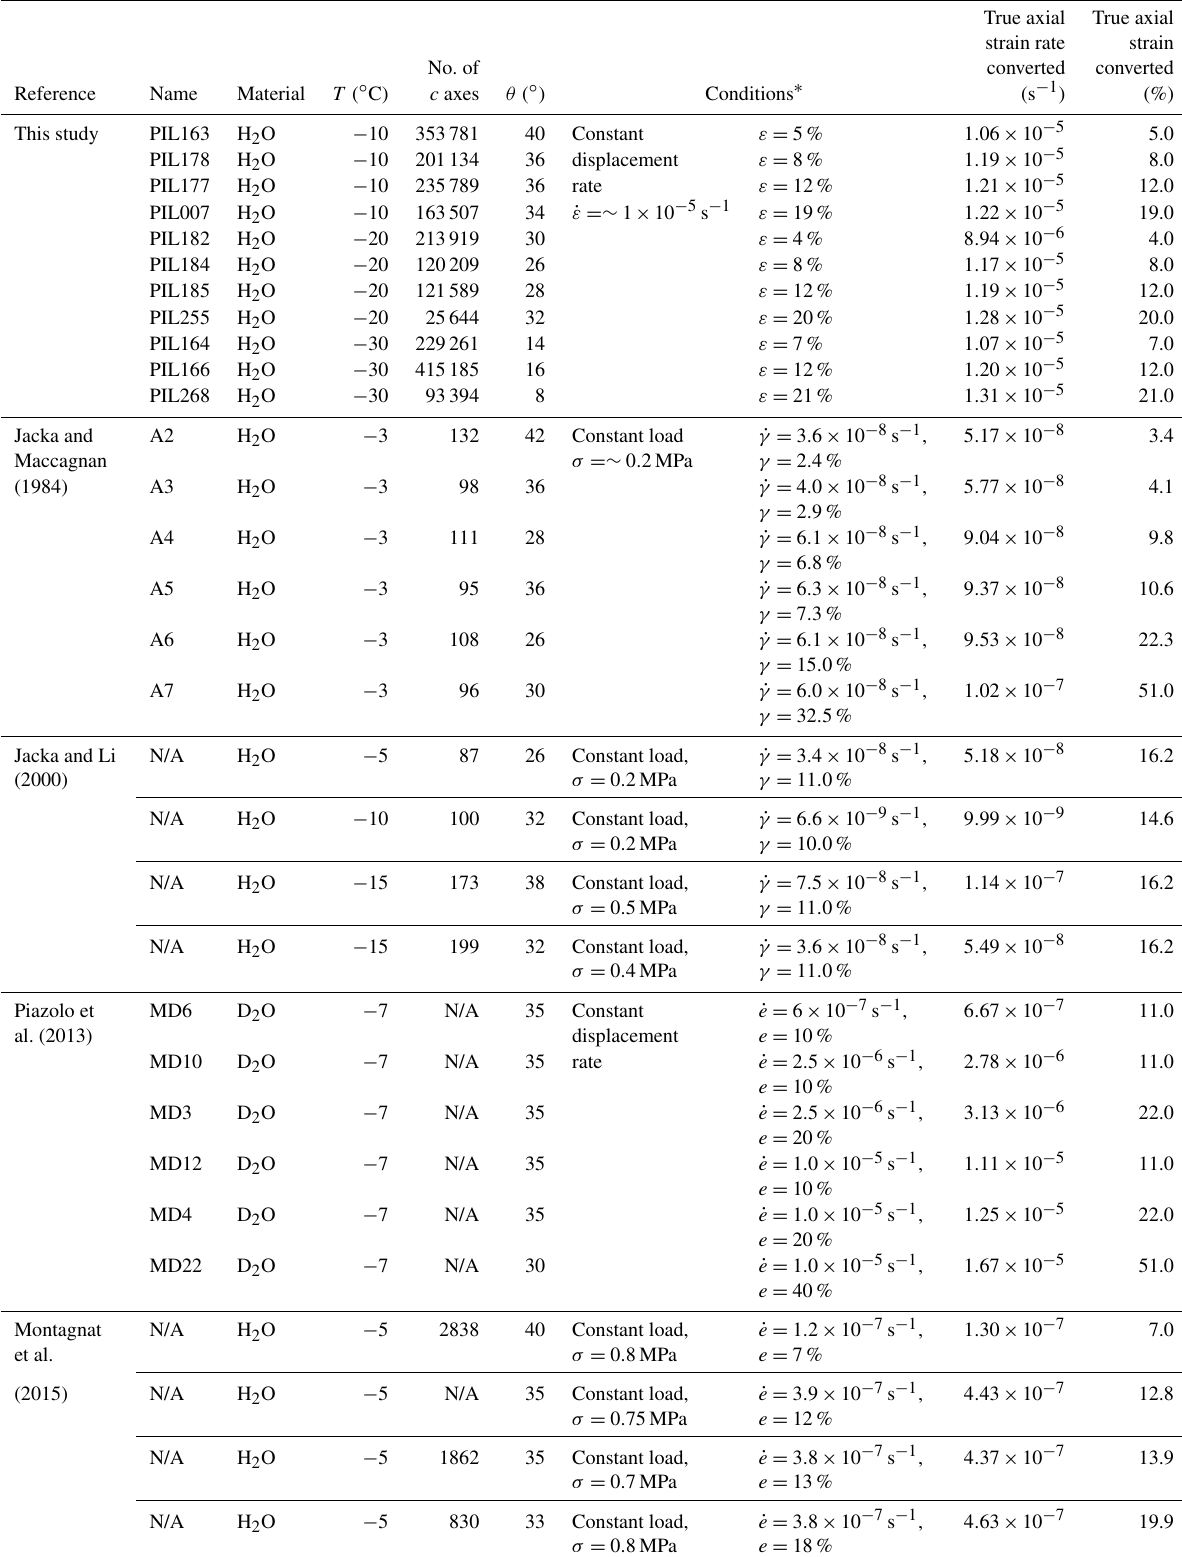
True axial True axial strain rate strain